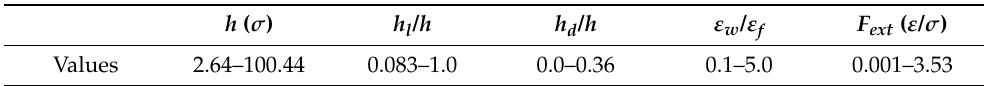
Table 2. Range of input data in reduced Lennard-Jones (LJ)